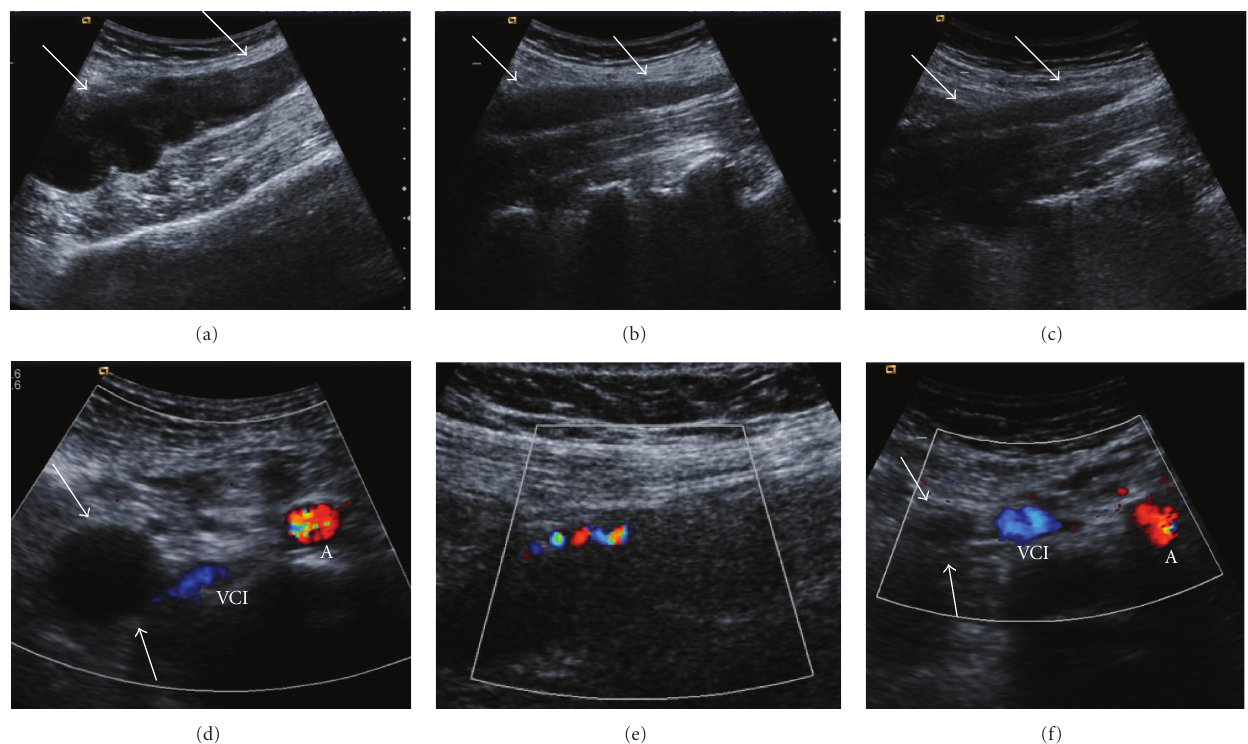
Figure 1: US and color Doppler US images obtained at first day ((a) and (d)), fourth month ((b) and (e)) and sixth month ((c) and (f)) show an enlarged, tortuous noncompressible tubular structure with hypoechoic material centrally, representing thrombosed right ovarian vein, extending superiorly from the right adnexa, lateral to the IVC (white arrows). With time, the width of the vein decreased. At fourth month, color Doppler US image shows flow with recanalization (e). VCI = vena cava inferior, A = abdominal